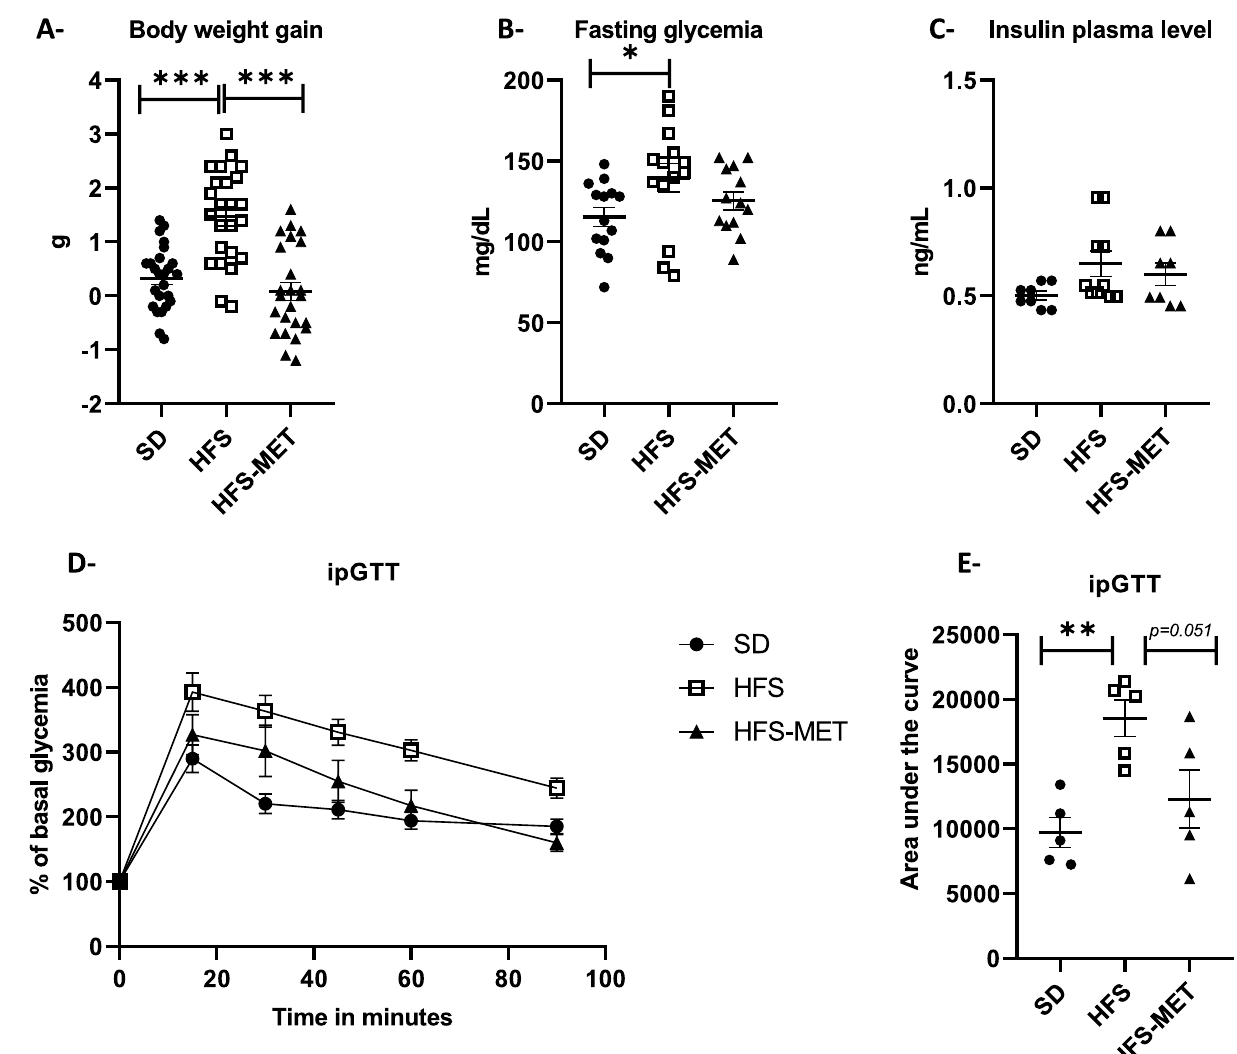
Figure 1. Metformin improves metabolic parameters and glucose tolerance in high fat high sucrose fed mice. ( A ) change in body weight after 8 days of standard diet (SD), high fat high sucrose diet without (HFS) or with metformin supplementation (HFS-MET). ( B,C ) Fasting plasma glucose and insulin concentrations, respectively. ( D ) Glycemic curves during intraperitoneal glucose tolerance test (ipGTT) performed on 5 animals per group, and ( E ) corresponding area under the curves (AUC) of the ipGTT. *p < 0.05, **p < 0.01, ***p < 0.001, determined by ANOVA followed by Tukey’s multiple comparison